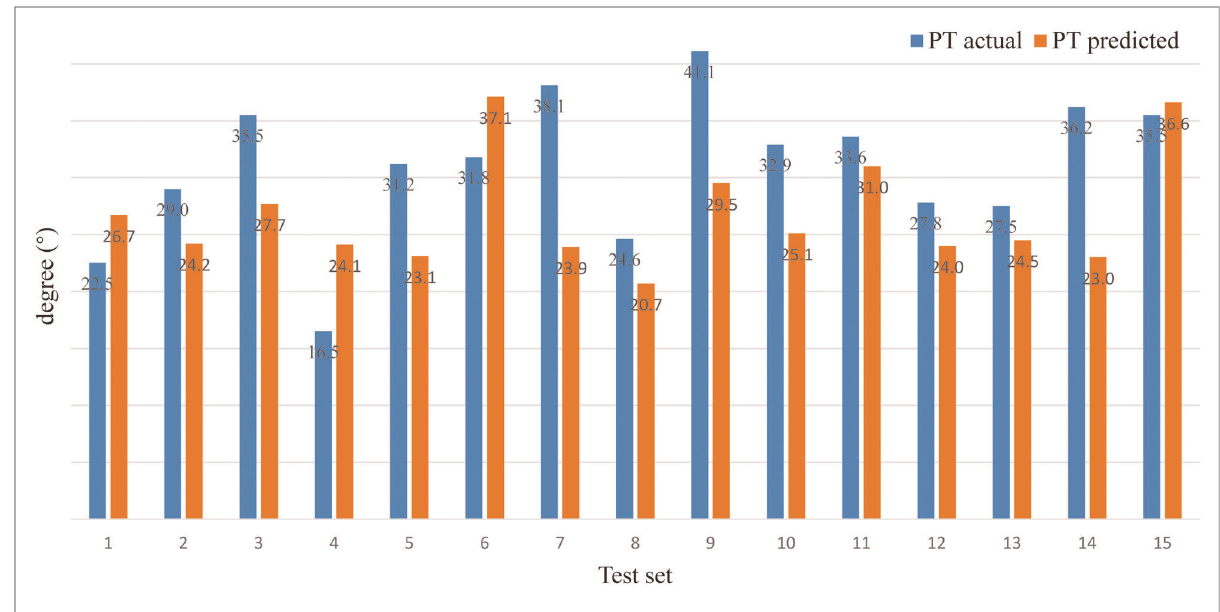
FIGURE 3 Comparison between the actual and the predicted values of sitting PT.